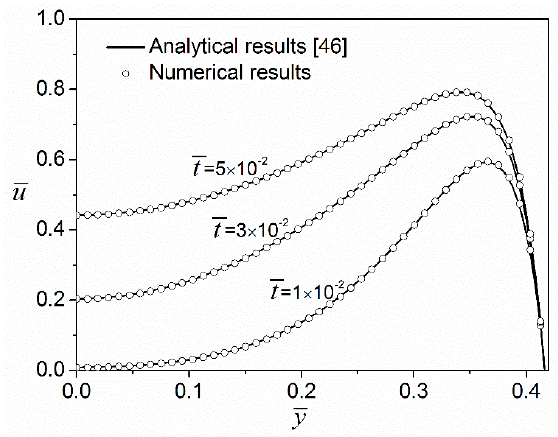
Figure 2. Transient velocity profiles along the y axis when z = 0 at three different time instants for Newtonian fluids ( n = 1.0) under a DC electric field E 0 = 1 and a zeta potential ψ w = −